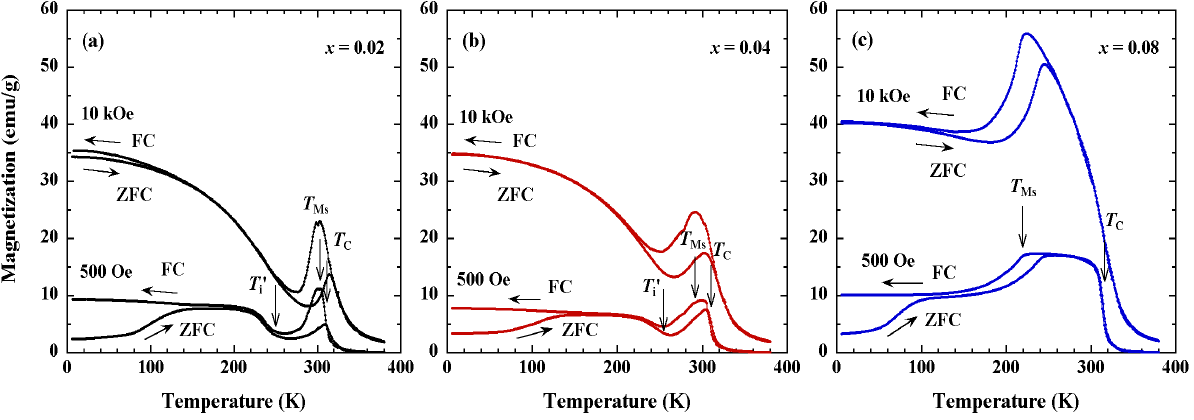
Figure 2. Thermomagnetization ( M - T ) curves measured under the magnetic fields of 500 Oe and 10 kOe for 57 Fe doped Ni M-T curve for x = 0.02 at 500 Oe is same as the reported previously [10]. The arrows with ZFC and FC along the curves in ( a ), ( b ) and ( c ) show the zero-field-cooling and field-cooling processes,